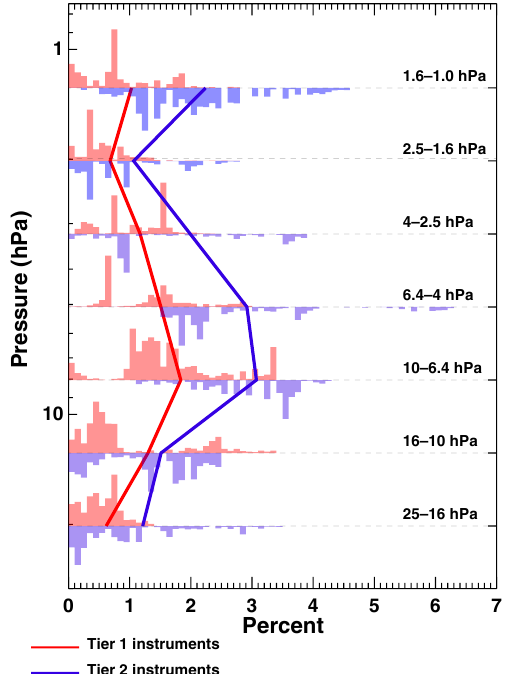
Figure 6. Drift parameters as a function of pressure level derived from Tier 1 and Tier 2 instrument overlaps used in Monte Carlo simulations to evaluate the uncertainty of potential offsets and drifts on final merged ozone record. For Tier 2 instruments, the NOAA 11_am to NOAA 14_pm relative drift is shown separately from that for NOAA 16_am to NOAA